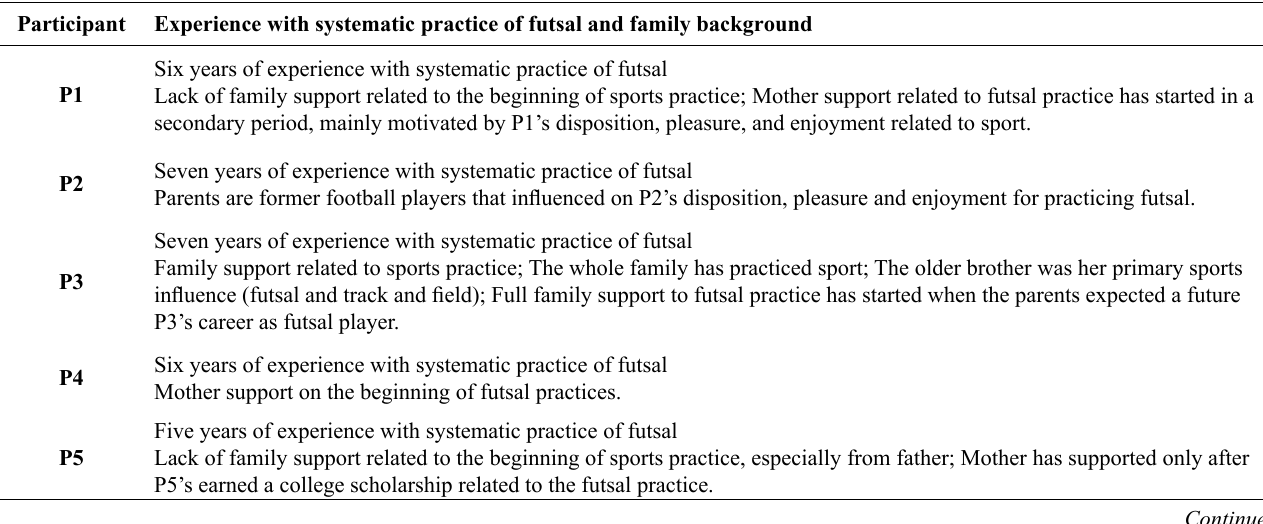
Table 1. Participants’ information and family